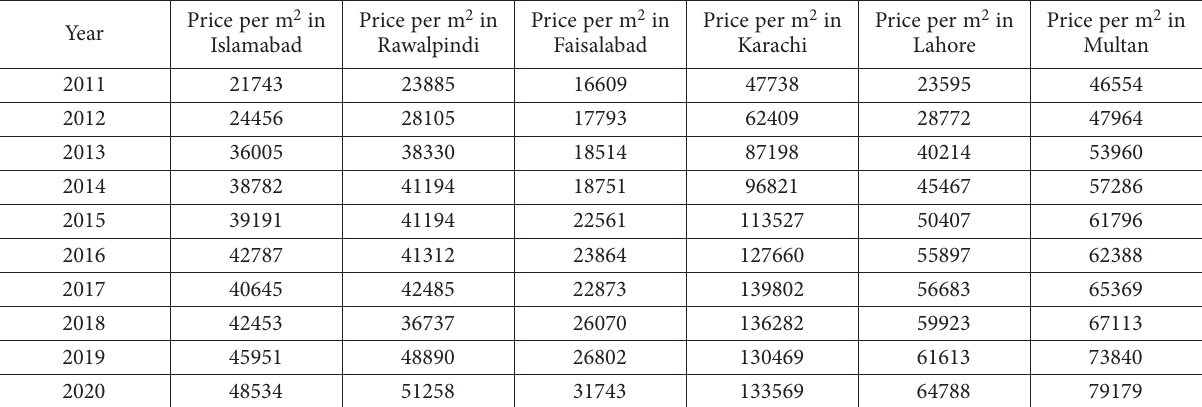
Table 2. Market prices of residential property in Pakistan (source: Zameen,